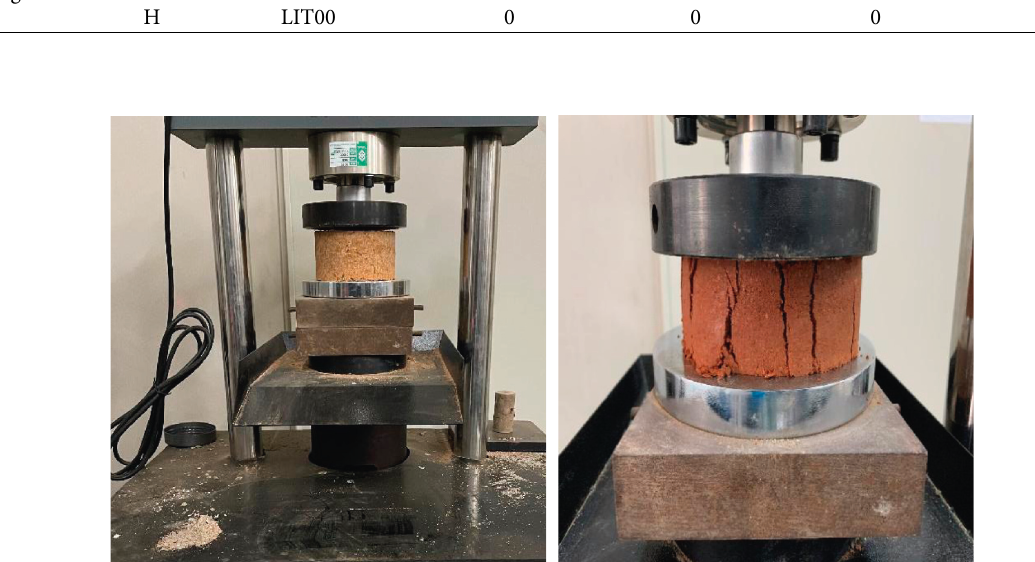
Figure 4: Uniaxial compression test instrument.